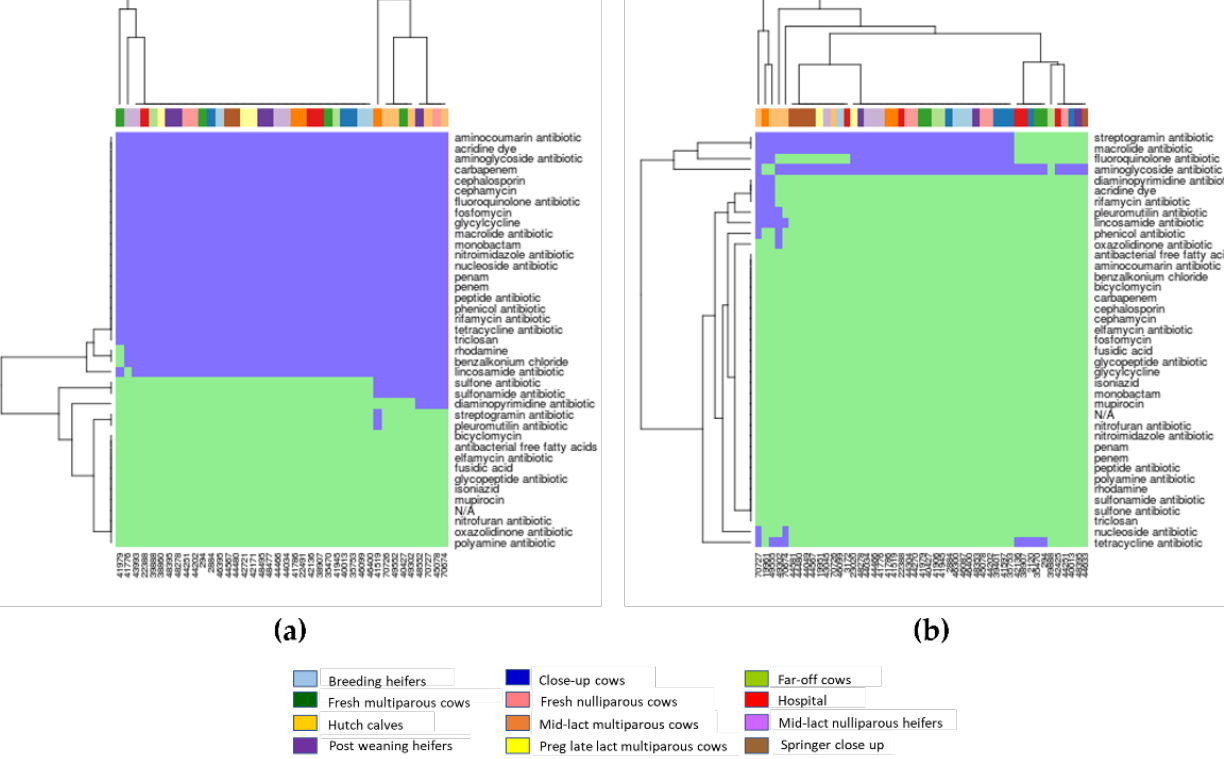
crobial classes, and horizontal axis is cattle IDs: ( a ) E. coli ; ( b ) Enterococcus.